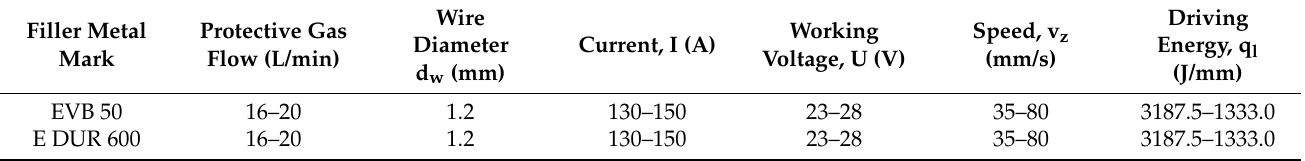
Table 9. Process parameters for the GMAW